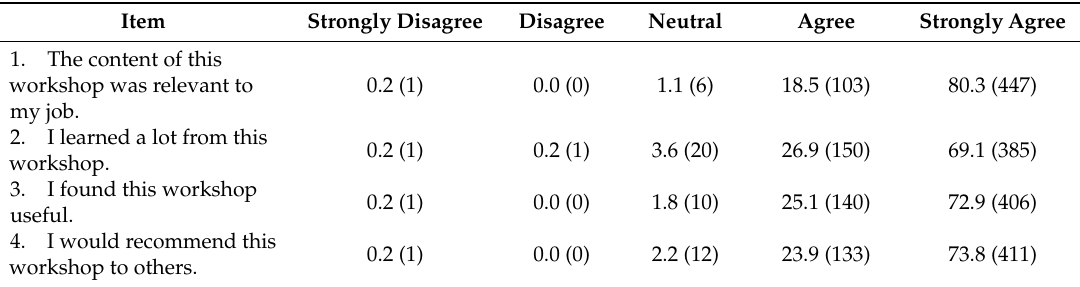
Table 3. Participants’ satisfaction ratings of the CSSS workshop % ( n